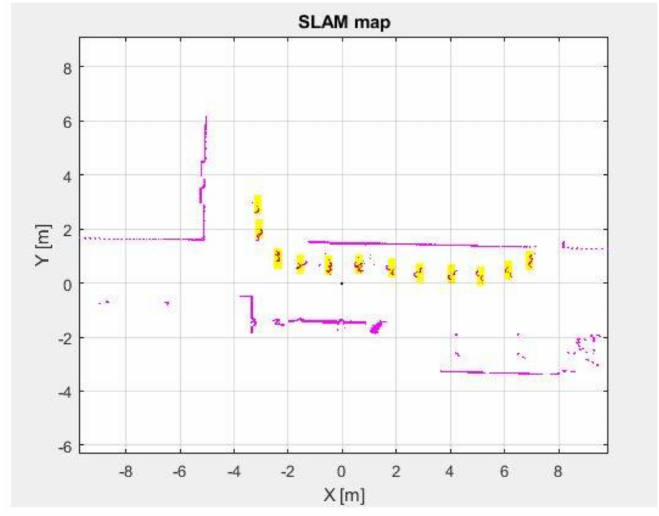
Figure 8. Map from SLAM algorithm for static